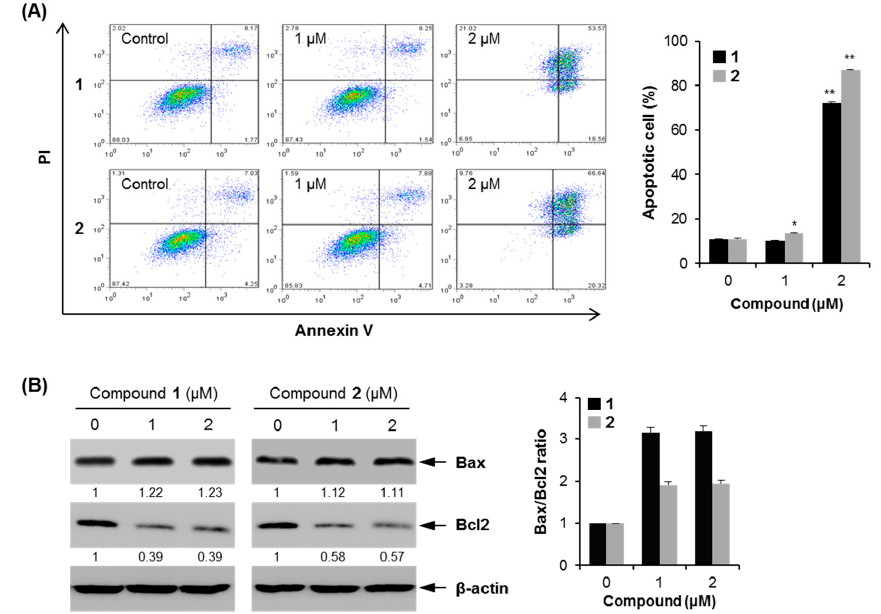
Figure 7. Cellular apoptosis by compounds 1 and 2 in MCF7 cells. ( A ) Flow cytometry was performed to measure cellular apoptosis. * p < 0.05; ** p < 0.01 vs. control; ( B ) western blot was performed using the indicated antibodies. The numbers represent the mean fold change of the respective protein levels in compounds-treated cells relative to the control cells. The Bax/Bcl2 ratio is shown as fold changes compared to that of the untreated cells.